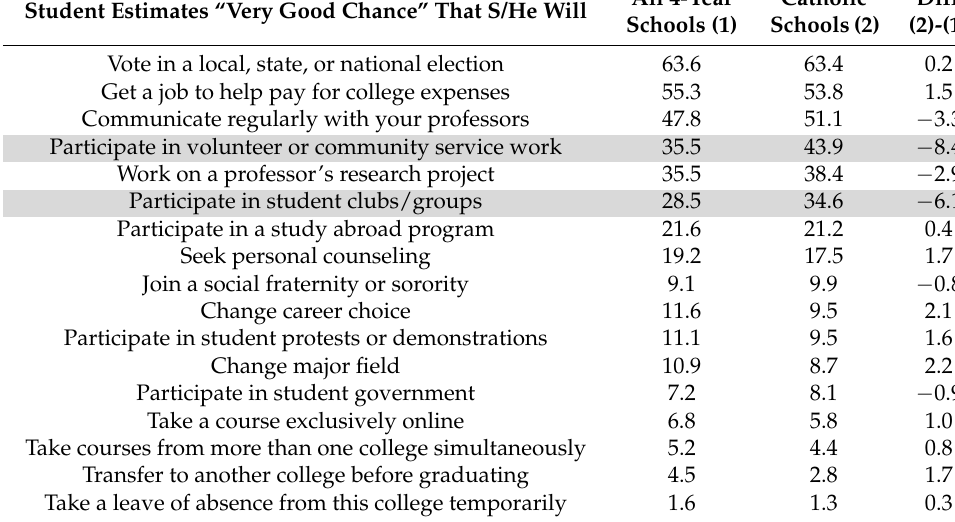
Table 3. Likelihood that Students Will Engage in Selected Practices [Ranked by Share for Catholic Institutions], 2019 CIRP Freshman Survey